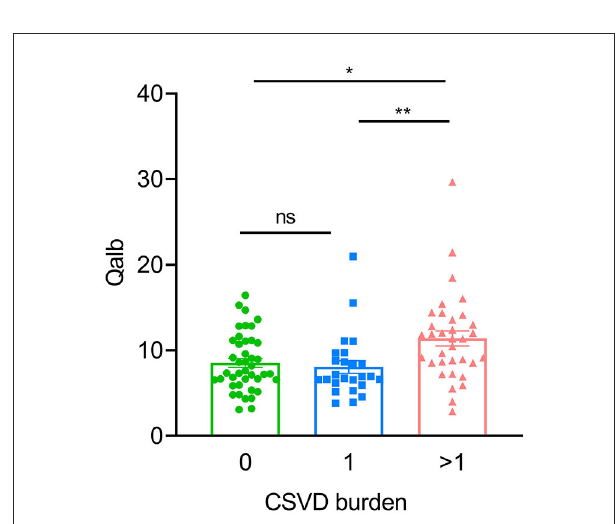
FIGURE2 Comparisons of Qalb values in patients with AD with different CSVD burdens. Each dot refers to the value of indicated measures of a single patient with AD. Error bars indicate SEM. * p < 0.05, ** p < 0.01; ns, not significant, Kruscal–Wallis